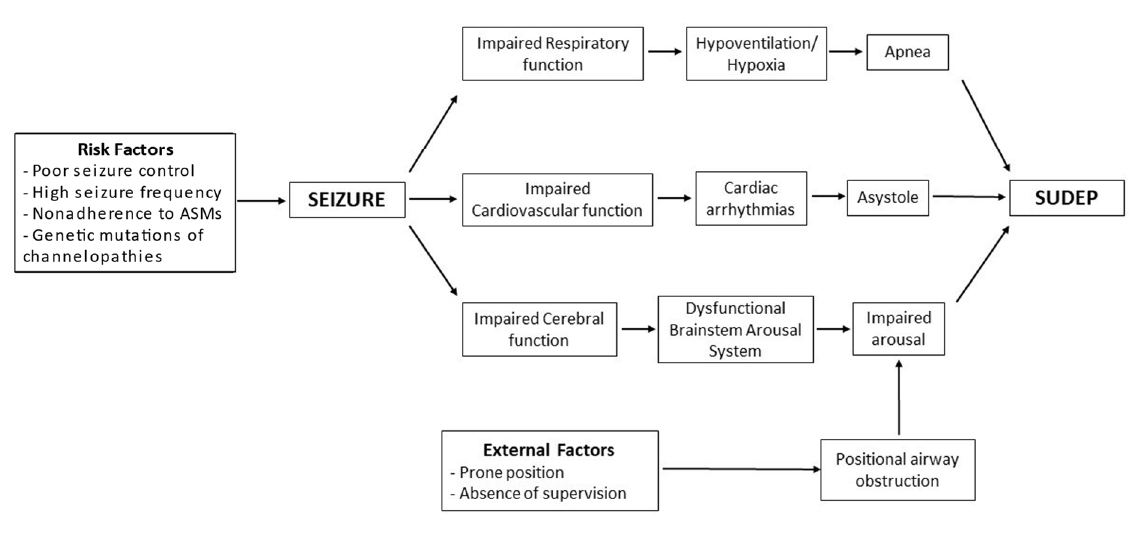
Figure 3. Pathophysiology model of